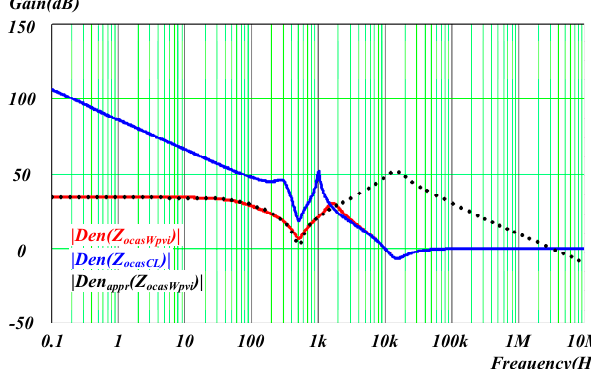
Figure 19. Bode plot of | Den(Z ocasWpvi )|, | Den appr (Z ocasWpvi ) | and | Den(Z ocasCL ) |.